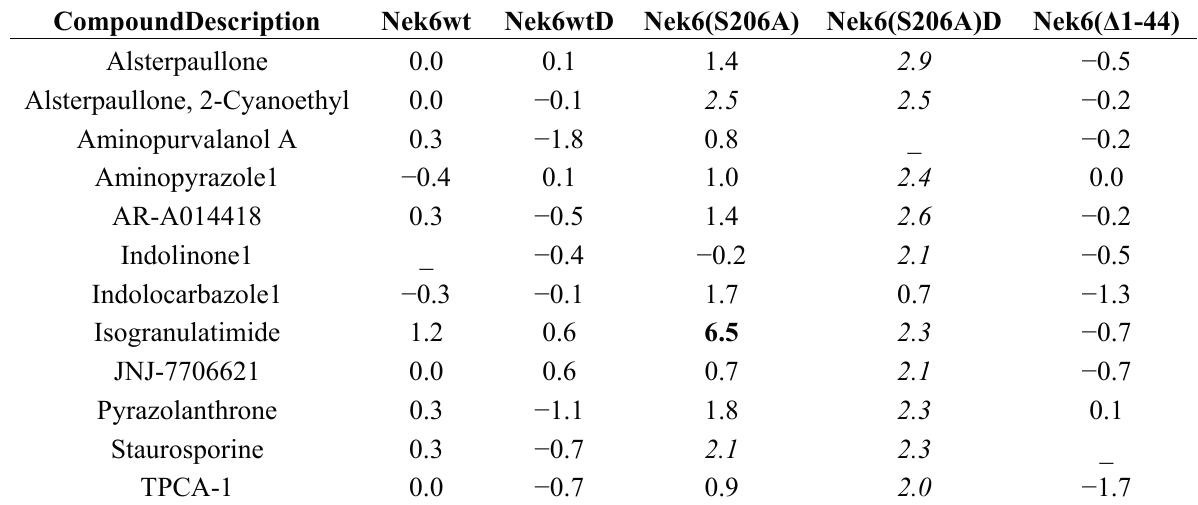
Table 2. Summary of hNek6 variants thermal shift inhibitor screen. A thermal shift of at least 2 °C ( Δ T m ≥ 2 °C) is depicted in italics and a significant thermal shift ( Δ T m > 4 °C) is depicted in bold. (D: